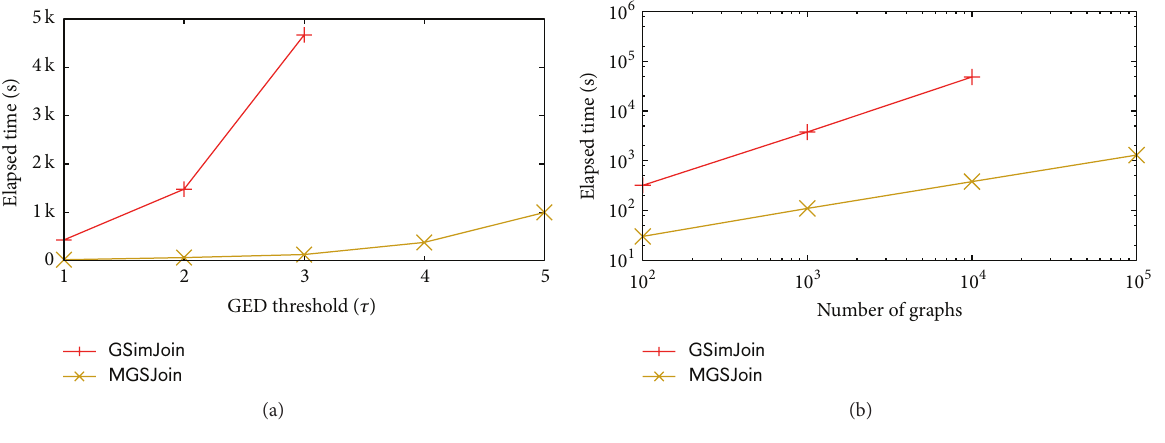
Figure 4: Comparing with state-of-the-art method.